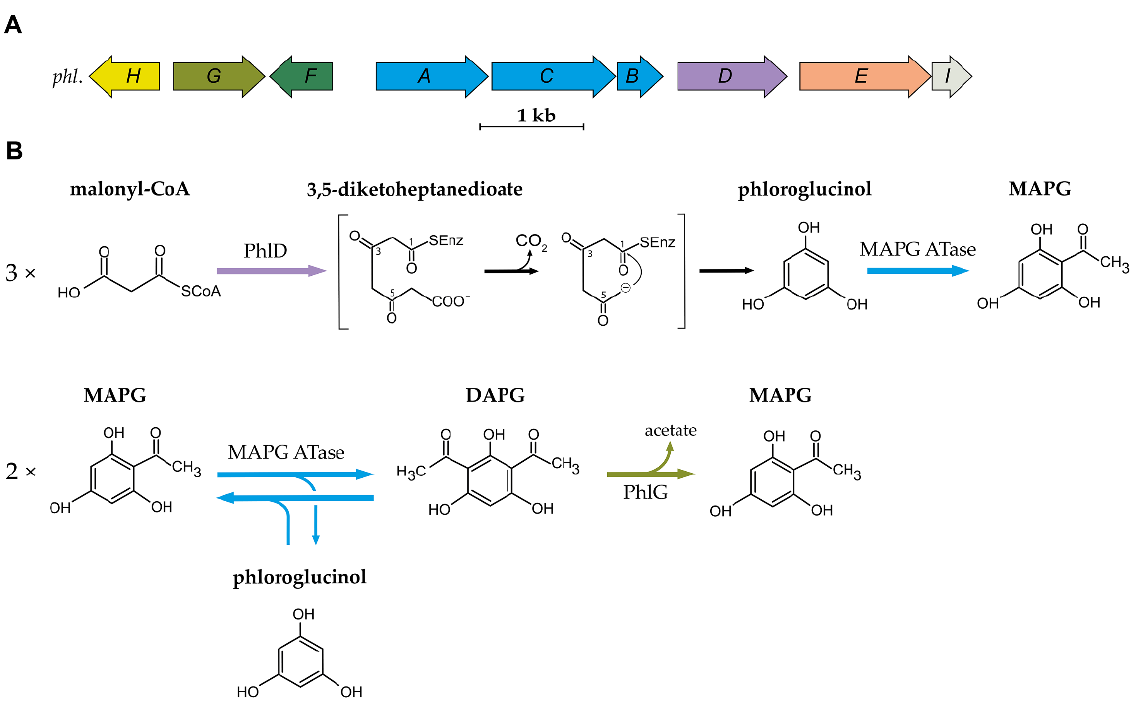
Figure 1. Organization of the 2,4-DAPG biosynthetic cluster and current understanding of the biosynthesis scheme. ( A ) Organization of the phl biosynthetic gene cluster found in DAPG-producing Pseudomonas spp. ( B ) Current understanding of the biosynthesis and degradation of DAPG in the genus Pseudomonas . MAPG ATase is an enzyme multiplex composed of PhlA, PhlB and PhlC units. Abbreviations are as follows: MAPG, monoacetylphloroglucinol; DAPG, 2,4-diace- tylphloroglucinol.